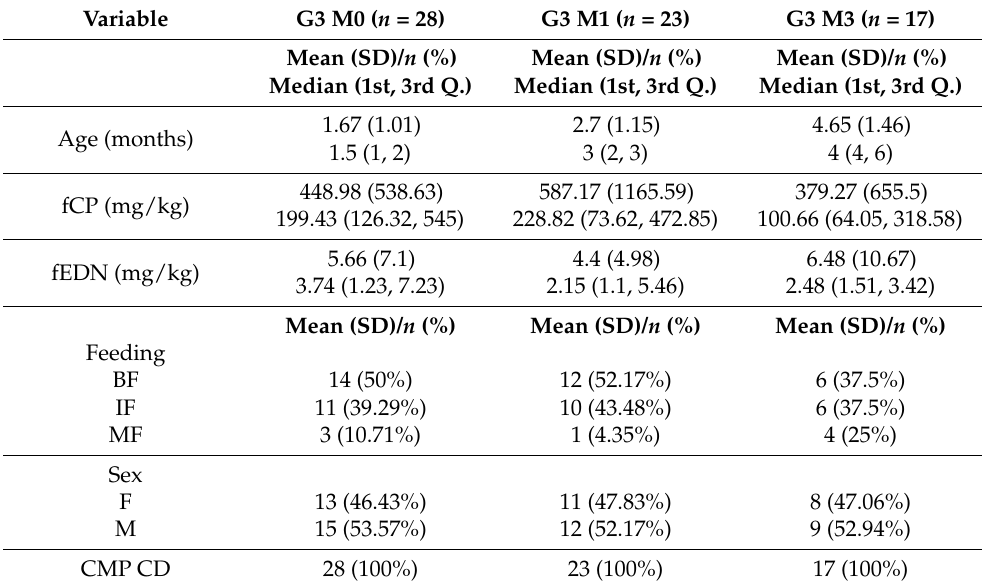
Table 2. Summary of fCP and fEDN in healthy children